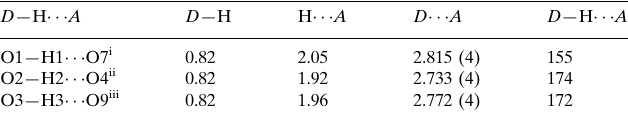
Hydrogen-bond geometry (A˚ , (cid:2)